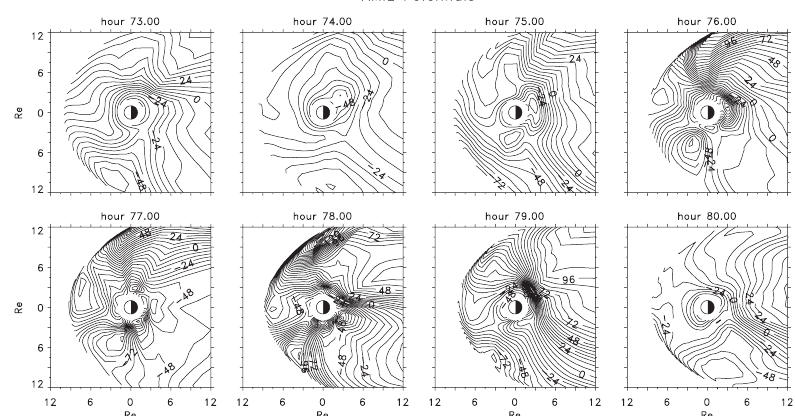
Fig. 4. Electric potential isocontour plots like Fig. 2, except for the AMIE electric field model. Note that corotation is included in the potential pattern.